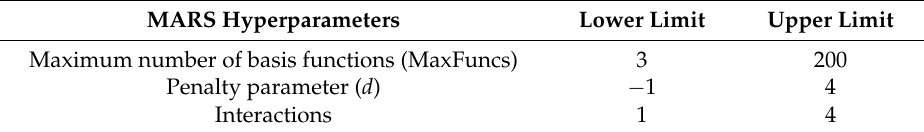
Table 2. Initial ranges of the three hyperparameters of the ABC–MARS-based model fitted in this study. MARS Hyperparameters